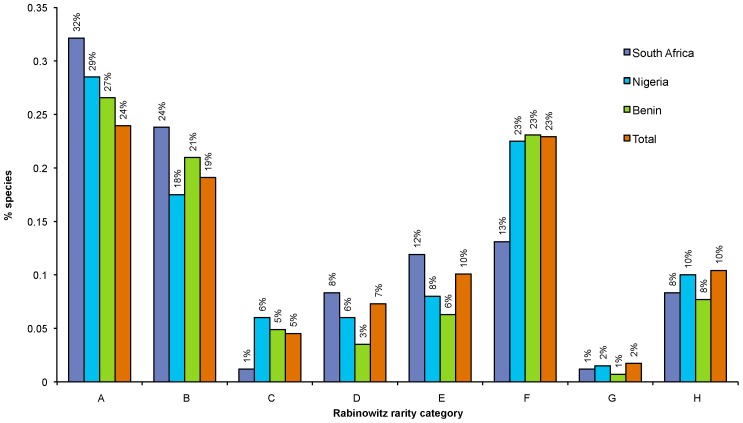
The observed proportion of traded species in each Rabinowitz category of commonness or rarity for two West African countries (Benin and Nigeria), for South Africa and the ‘Total’ for seven countries combined.